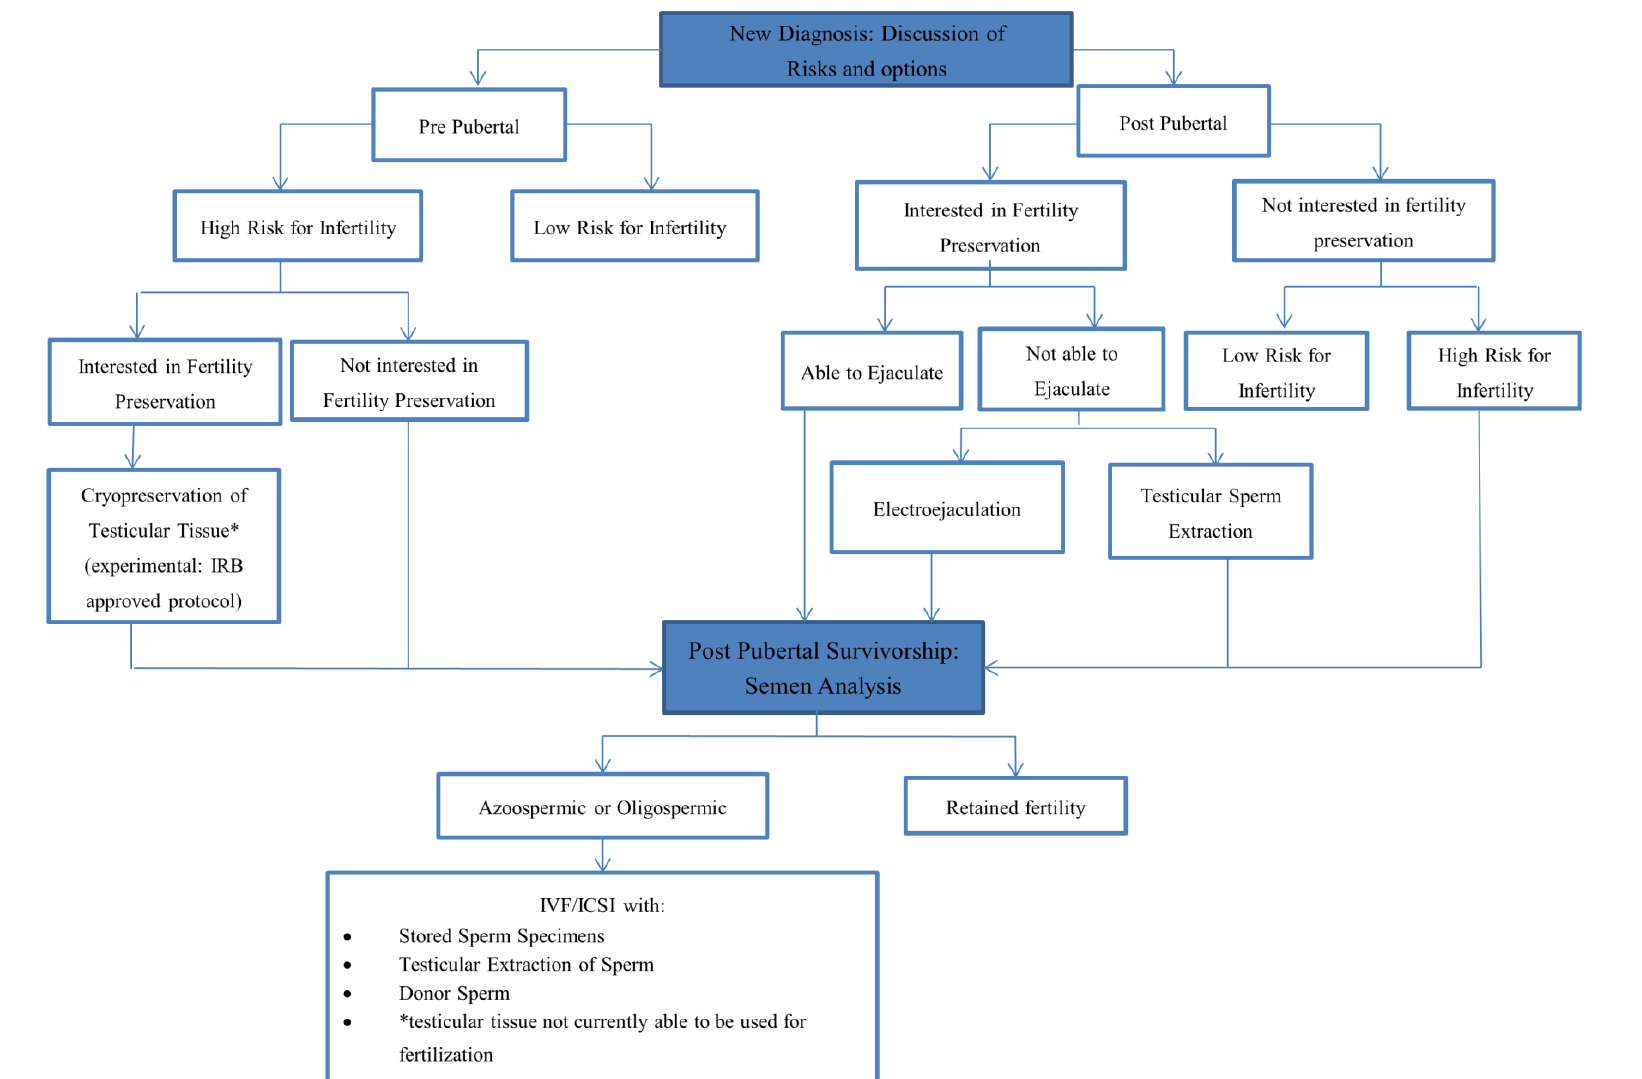
Figure 1. Algorithm of fertility preservation options for